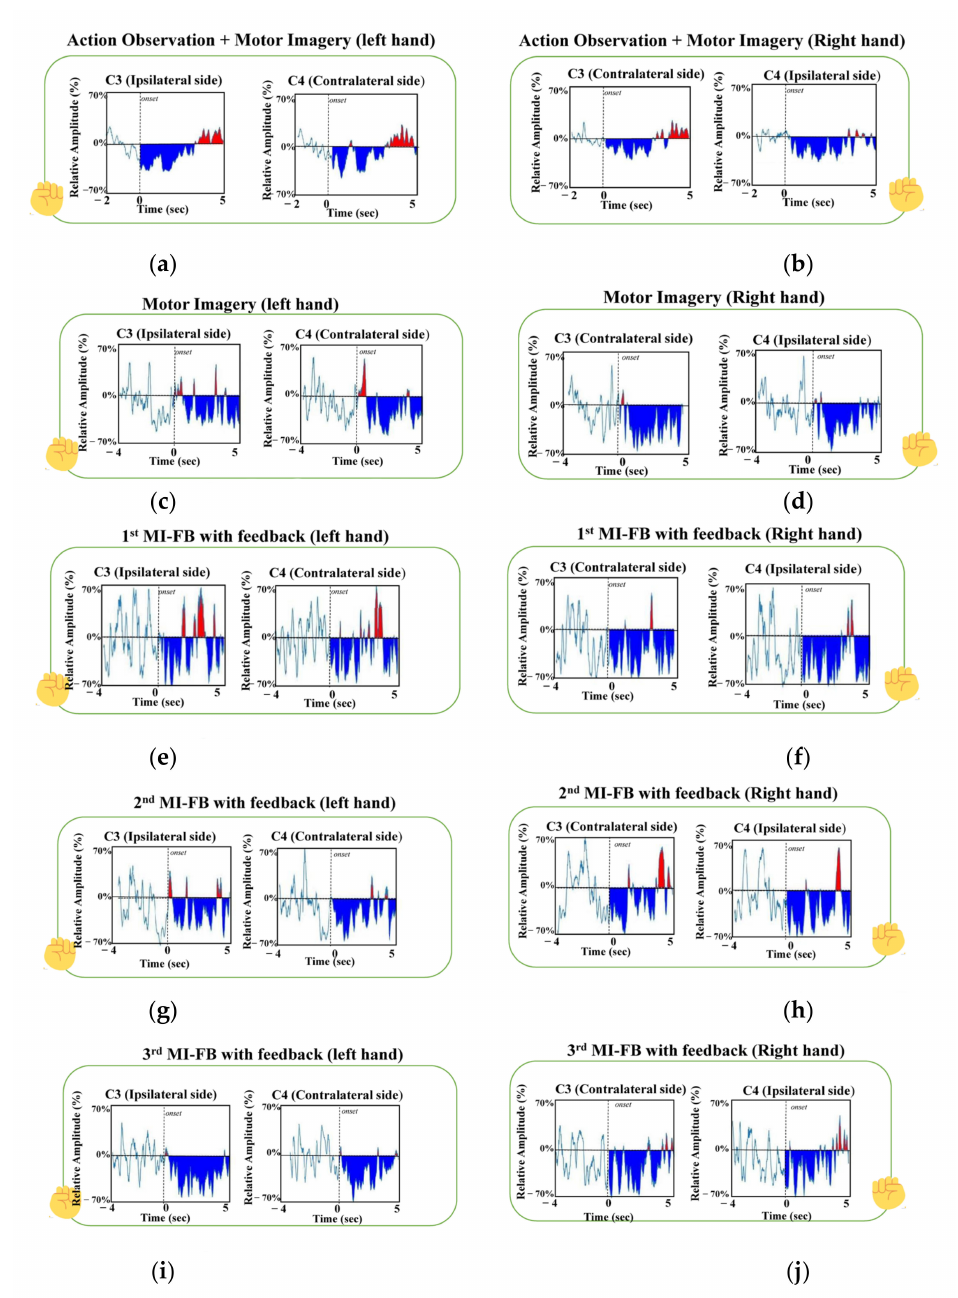
Figure 7. The RPs obtained from the average of the five subjects in the four datasets. The ERD and ERS are marked in blue and red colors, respectively. ( a ) The RP changes in the left-hand AO + MI task. ( b ) The RP changes in the right-hand AO + MI task. ( c ) The RP changes in the left-hand MI task. ( d ) The RP changes in the right-hand MI task. ( e ) The RP changes of the left-hand imagery movement in the first MI-FB task. ( f ) The RP changes of right-hand imagery movement in the first MI-FB task. ( g ) The RP changes of left-hand imagery movement in the second MI-FB task. ( h ) The RP changes of right-hand imagery movement in the second MI-FB task. ( i ) The RP changes of left-hand imagery movement in the third MI-FB task. ( j ) The RP changes of right-hand imagery movement in the third MI-FB